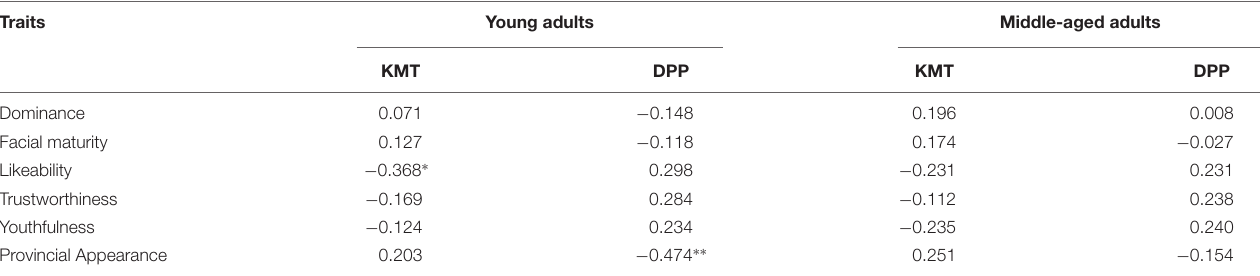
TABLE 2 | The Pearson’s correlations between young and middle-aged adults’ trait rating scores for KMT and DPP candidate photos in Experiment 2 and the young adults’ political membership categorization accuracy in Experiment 1.